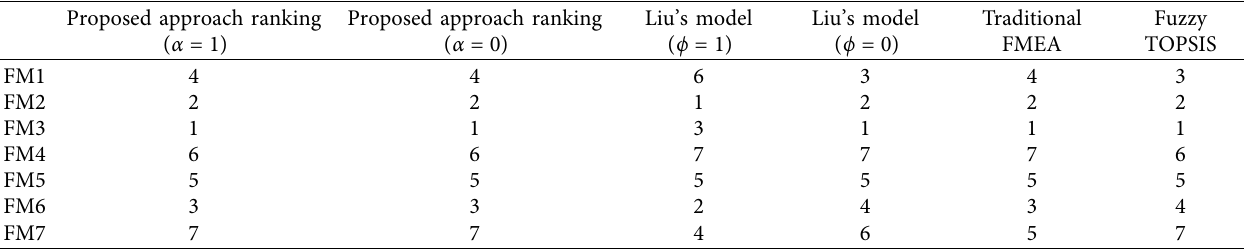
Table 9: Ranking comparison.